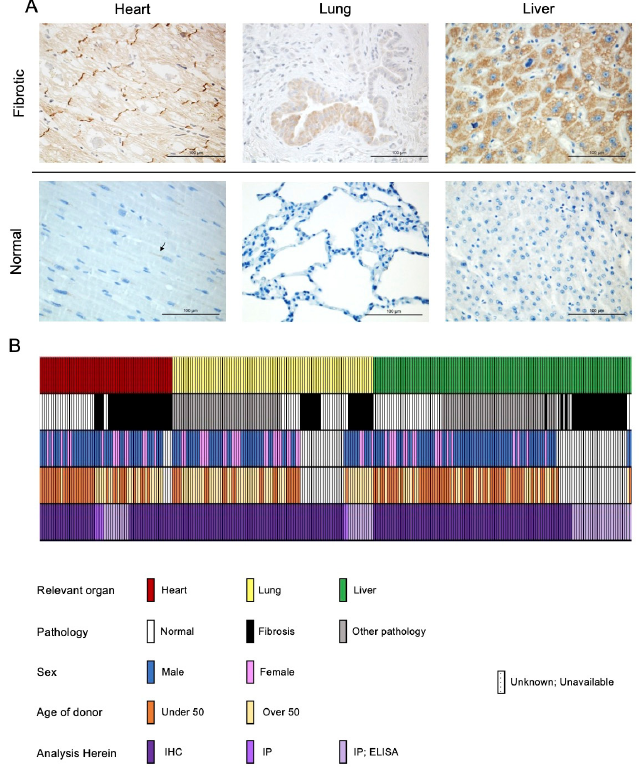
Figure 1. PNC is aberrantly expressed in fibrotic heart, lung, and liver tissues. ( A ) Representative images of stained tissues from explanted failed human hearts ( n = 20, ischemic and non-ischemic etiology), lungs ( n = 10, IPF etiology) and livers ( n = 40, NAFLD-cirrhosis etiology) show positive expression and aberrant localization of PNC (Brown stain). Corresponding representative images of stained normal human heart ( n = 24), lung ( n = 18), and liver ( n = 32) show lack of aberrantly expressed PNC at the tissue level. Perinuclear staining, consistent with normal N-cadherin pro- cessing can be seen in the healthy cardiac tissue. Scale bar = 100 µm. ( B ) Graphical representation of human samples analyzed in this study. Each column represents a single human sample, annotated by color to indicate the organ system of relevance to this study (top row), whether the patient had fibrosis (second row), the reported sex of the patient (third row), the age of the patient (fourth row) and the method by which the sample was analyzed in this study (fourth row). In cases where de- mographic data is unknown, unavailable, or unreported, a white bar with black hatch is shown. n = 257 total samples analyzed. To validate the specific presence of aberrantly localized PNC in the case of failing cardiac tissue, a sample of healthy human heart tissue, obtained by surgical excision dur- ing a heart transplant procedure, was processed and stained for the presence of PNC, in addition to a human tissue microarray of 24 unique samples of healthy human heart tis- sue. While cardiac tissue is known to have high protein expression of mature N-cadherin, we observed no aberrantly localized PNC in the healthy hearts. Perinuclear staining found in healthy cardiac tissue is consistent with normal physiology and N-cadherin processing. These data indicate that aberrant PNC localization in the myocardium is a potential bi- omarker of the failing heart. Tissues that were obtained fresh immediately post-explant were divided, mechanically and enzymatically digested, and isolated as cell monolayers. These isolated fibroblasts were positive for myofibroblast markers α -SMA and type I col- lagen by flow cytometry (Supplementary Figure S1 A,B). Additionally, all other fibroblast